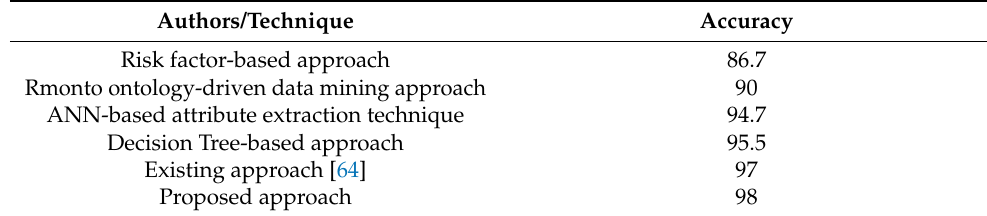
Table 12. Analysis in accordance with Accuracy